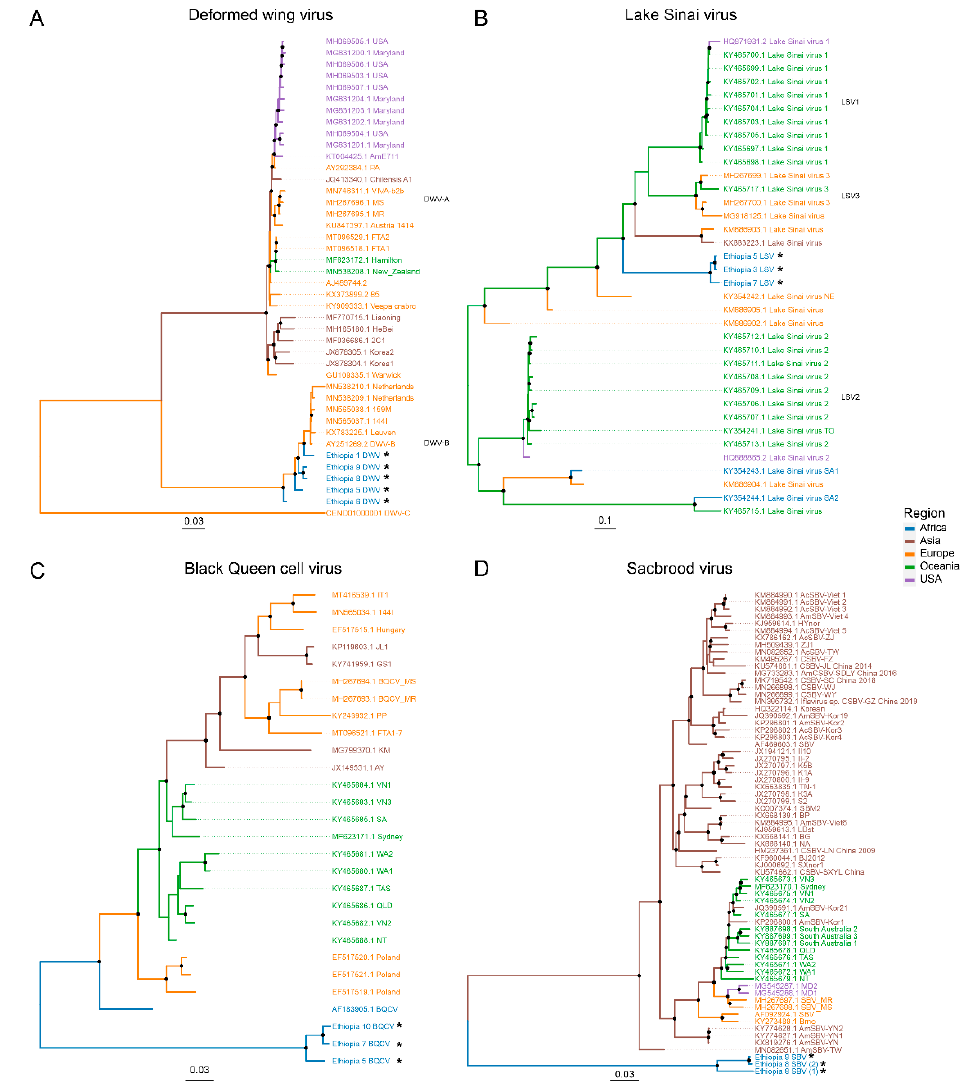
Figure 5. Phylogenies of known honey bee viruses: deformed wing virus ( A ), Lake Sinai virus ( B ), black queen cell virus ( C ) and sacbrood virus ( D ). Midpoint-rooted phylogenetic trees were drawn based on near-complete genome alignments (on nucleotide level). Bootstrap values exceeding 70% are indicated as black circles on their respective nodes. Tip labels as well as branch groups are colored according to the geographical location of which the sequence was derived. Sequences retrieved in this study are indicated in blue, with asterisks. A multifasta-file of these sequences is provided as Supplementary